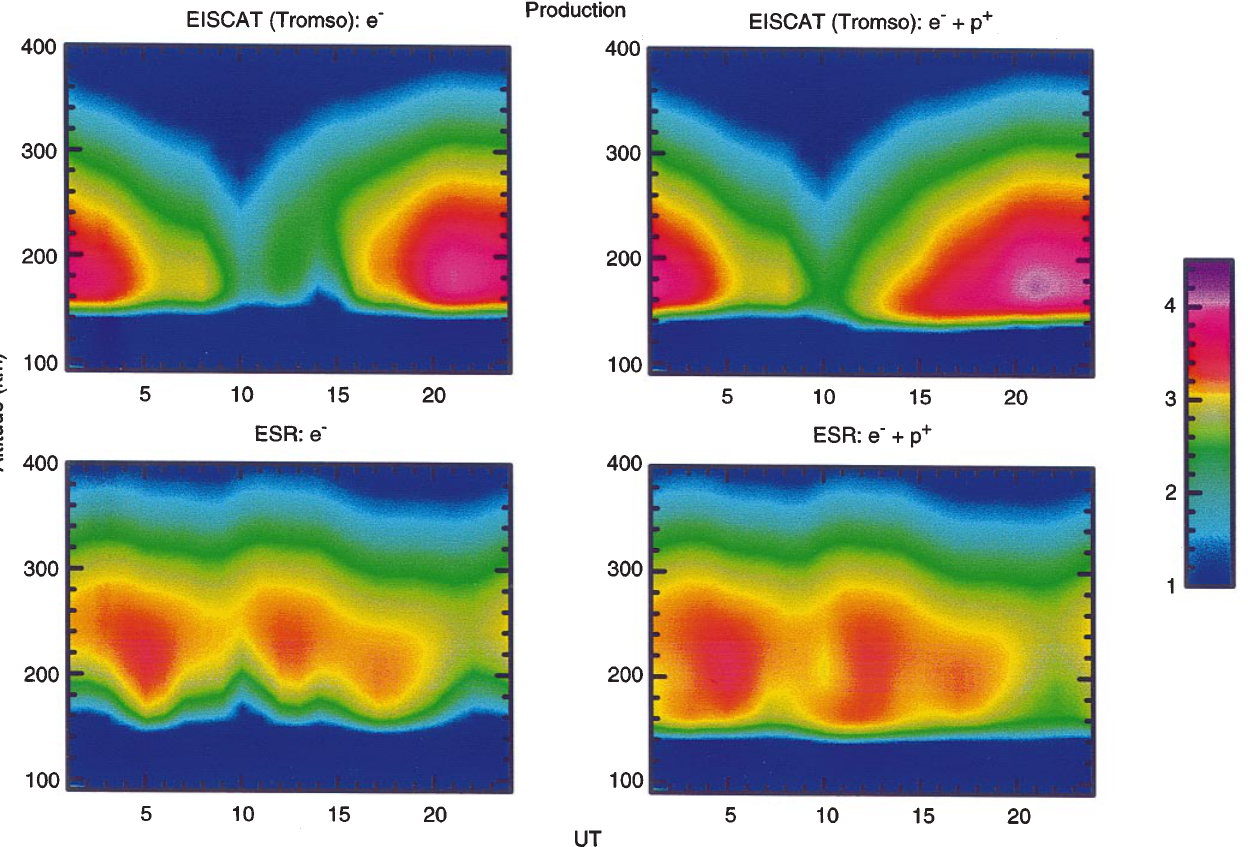
Fig. 9. The two left panels show the e(cid:128)ect of the electron precipitation from the Hardy model above EISCAT (Tromsø) ( top ) and ESR ( bottom ) on the electron production, in electron (cid:225) cm ) 3 (cid:225) s ) 1 . The e(cid:128)ect of coupled electron/proton precipitation is shown in the two right